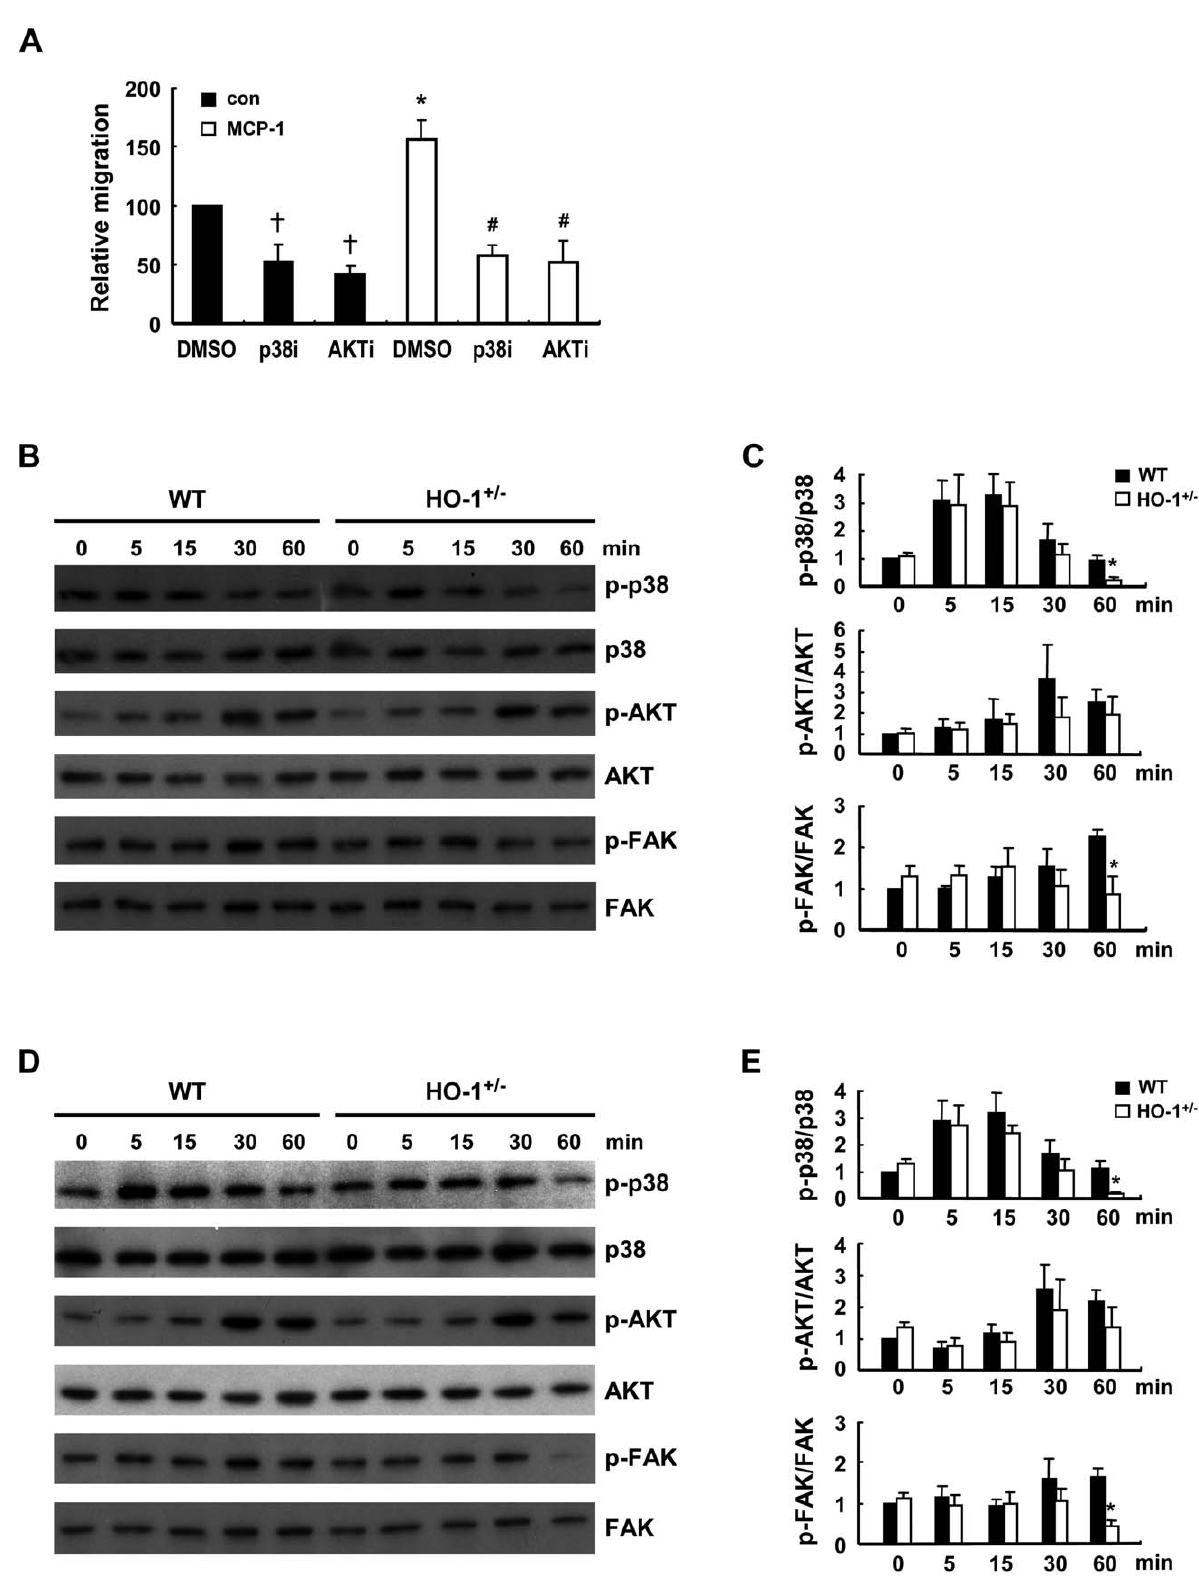
Figure 7. HO-1 influences chemoattractant-induced signaling. A, WT peritoneal macrophages were tested in an MCP-1 (10 ng/ml)-induced transwell migration assay in the absence or presence of SB203580 (20 m M; p38i)) or Akt inhibitor VIII (10 m M; AKTi). The data are the mean 6 SEM for three independent experiments. * and { P , 0.05 vs the corresponding control group; # P , 0.05 vs the MCP-treated group. B-E, Peritoneal macrophages isolated from WT and HO-1 + / 2 mice were stimulated with 10 ng/ml of MCP-1 (B &C) or VEGF (D &E) for the indicated times, then the phosphorylation